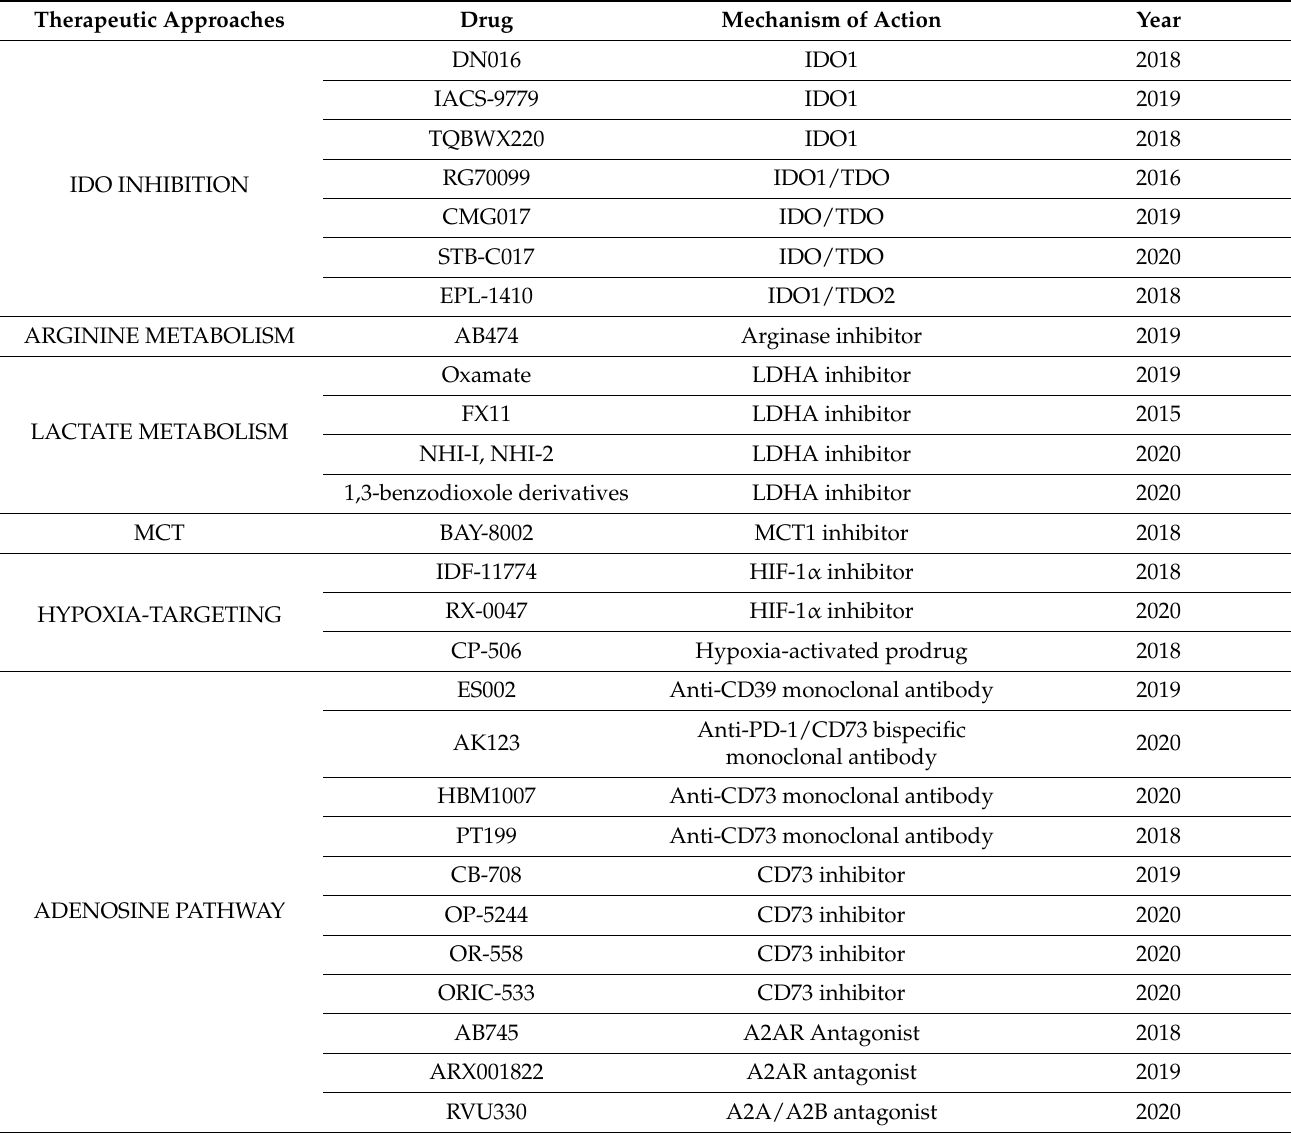
Table 2. Therapeutic approaches targeting tumor microenvironment metabolism under preclinical evaluation. Therapeutic